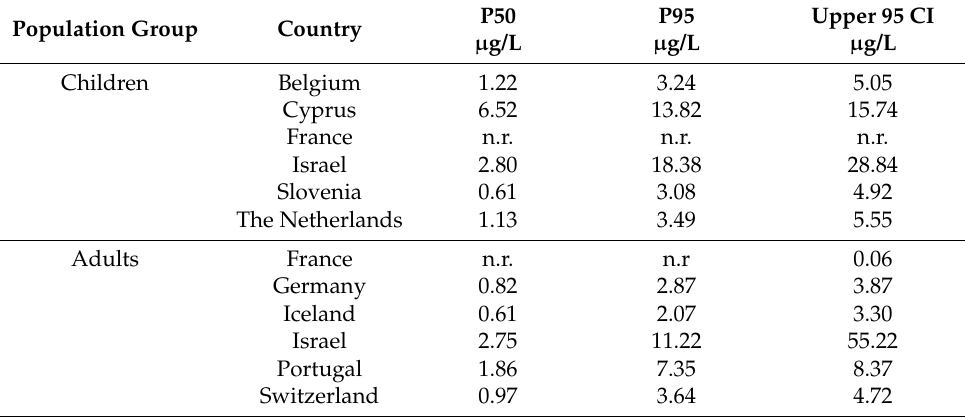
Table 2. Selected aggregated TCPy HBM data from HBM4EU-aligned studies. For France, some values are not reported (n.r.) due to high percentage of samples below the level of detection. Population